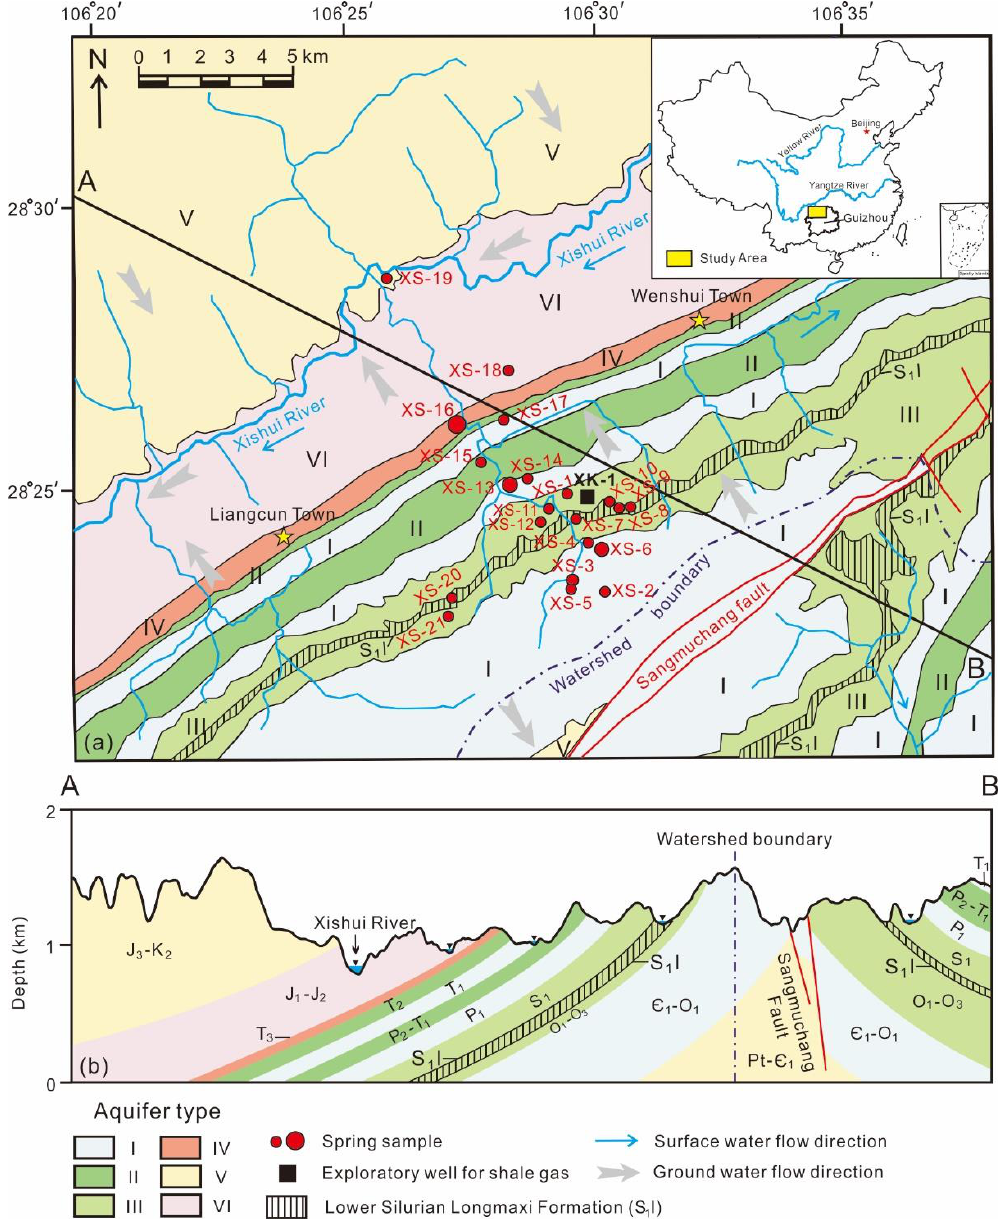
Figure 1. Study area. ( a ) The planimetric map with the distribution of aquifers; ( b ) the section map of aquifers. The introduction of aquifer types can be found in the text. The bigger dots indicate the spring water samples with higher discharges, while the Lower Silurian Longmaxi Formation (S 1 l) is the target stratum for shale gas exploration.